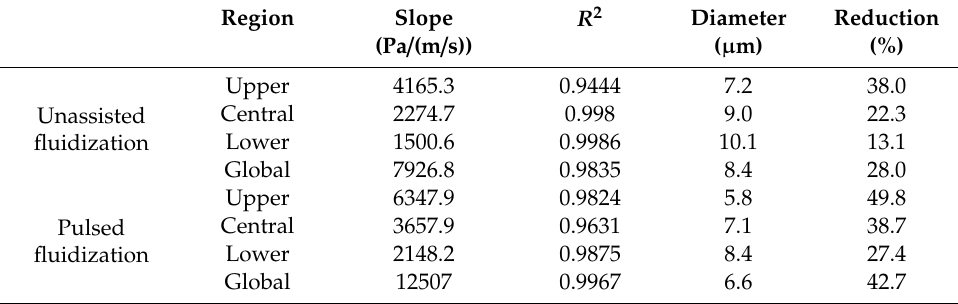
Figure 15. Globalpressuredropvariationswithvelocityandcorrespondinglinear-fitsforthedefluidization Figure 15. Global pressure drop variations with velocity and corresponding linear-fits for the cycles of unassisted and pulsed fluidized beds. defluidization cycles of unassisted and pulsed fluidized beds. Table 1. E ff ective agglomerate diameter in di ff erent regions of the fluidized bed and percent reduction using particle diameter obtained using particle size